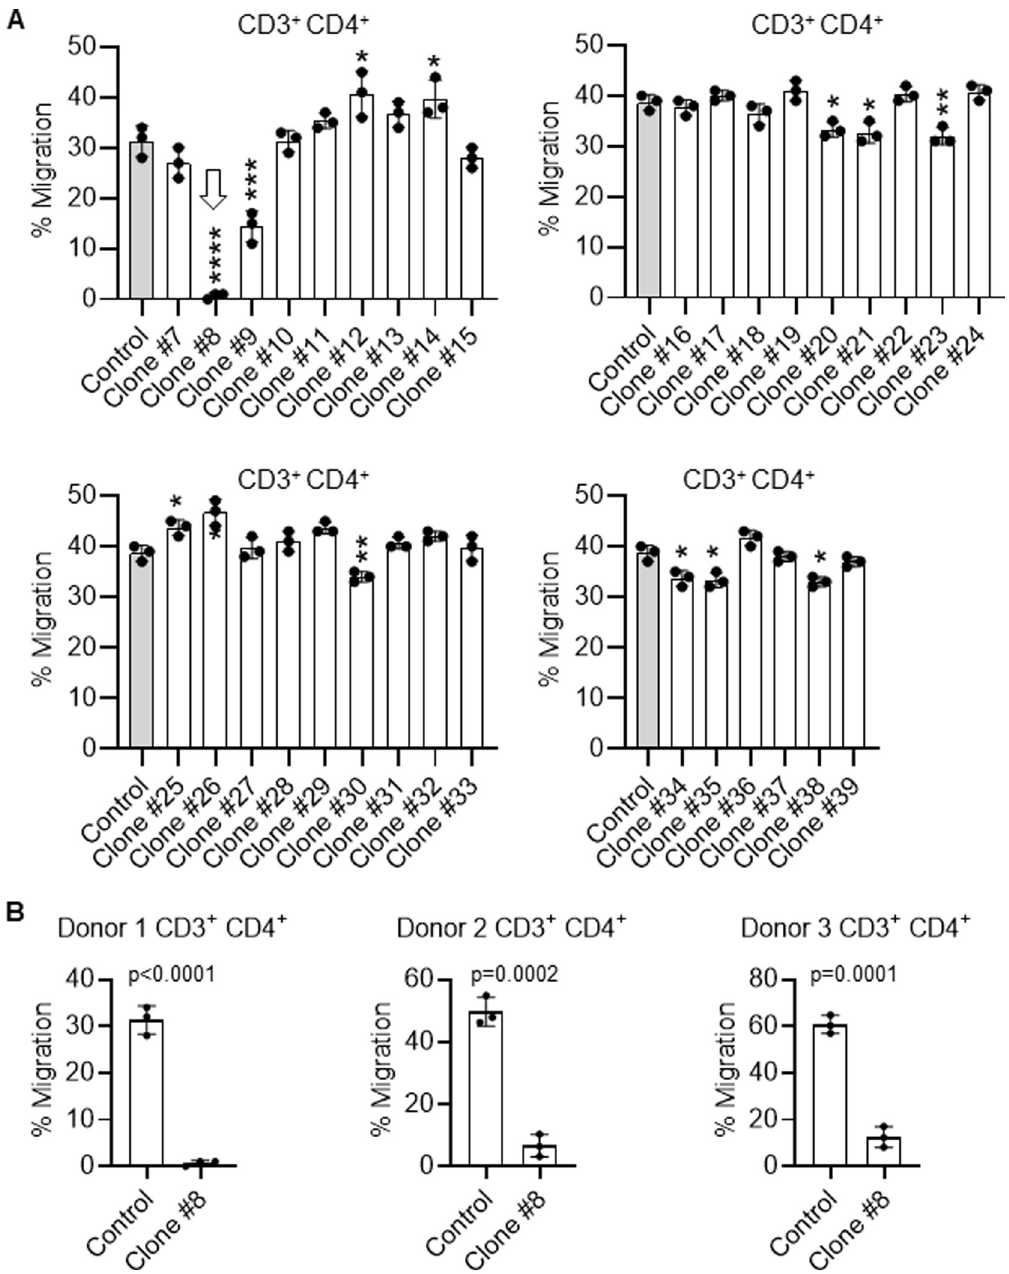
Fig 2. Screening of monoclonal antibody clones against CCL21-mediated T-cell chemotaxis. A) Inhibition of migration in transwell chemotaxis assays of human helper T-cells (CD3 + /CD4 + ) towards human CCL21 by the 33 murine monoclonal antibody clones that passed the screening process outlined in Fig 1. Clone 8 (C8) completely abrogated T-cell migration towards CCL21, while clone 9 partially inhibited migration. Several clones promoted migration of T-cells, suggesting they enhanced CCL21 presentation to its receptor, CCR7. B) C8 also blocked migration of three distinct normal donor human Th- cells towards CCL21, indicating this is a general phenomenon. For all migration assays, data are the mean ± SD of triplicate wells, performed twice. Student T tests were performed for statistical analysis for this figure and Fig 3. � p < 0.05, �� p < 0.01, ��� p < 0.001 and ���� p < 0.0001 when compared to control. https://doi.org/10.1371/journal.pone.0252805.g002 recognized by C8 in 6 of 8 cases of psoriasis, the positive controls (Fig 4, right upper panel) [15]. We used rheumatoid arthritis as a negative control since T-cell infiltration in this